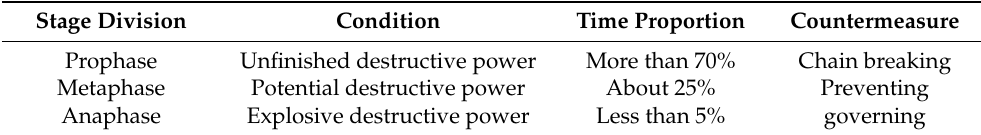
Table 10. The broken chain theory.